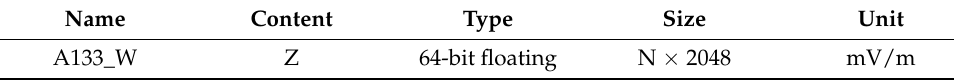
Table 1. Description of electric field VLF band data format